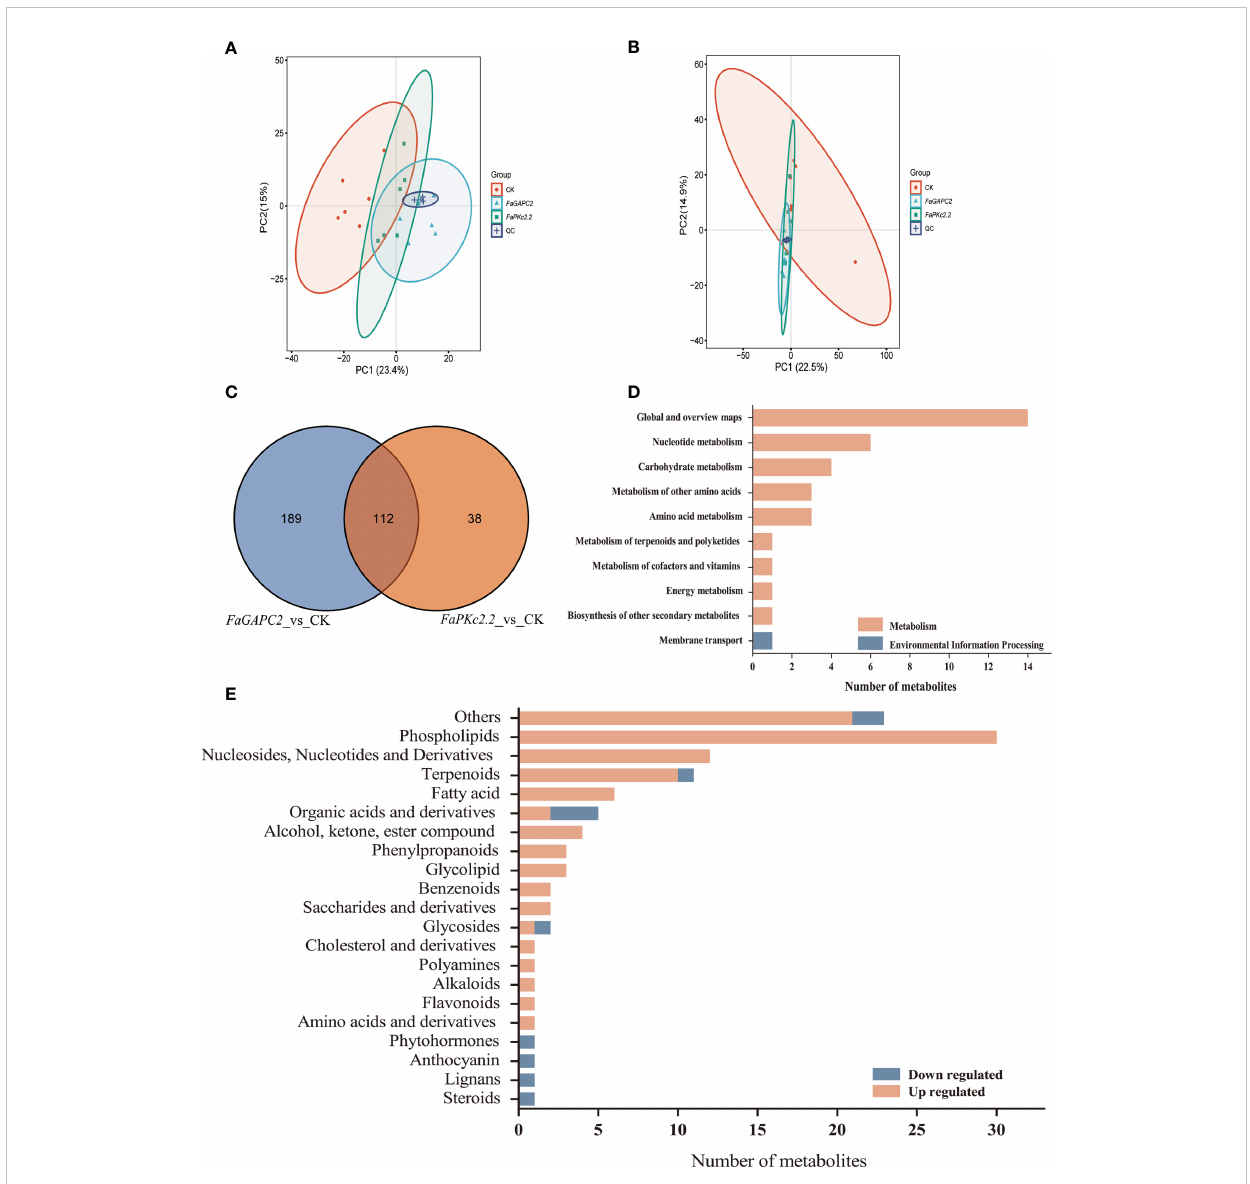
FIGURE 3 Analysis of differential metabolites in FaGAPC2 / FaPKc2.2- overexpressed fruits. Principal component analysis (PCA) score plots of strawberry fruit samples in negative ion modes (A) , PCA score plots of strawberry fruit samples in positive ion modes (B) , the Venn diagram analysis (C) , the KEGG annotation of common differential metabolites (D) , classi fi cation and the number of all the identi fi ed differential metabolites in the FaGAPC2 / FaPKc2.2 -overexpressed fruits (E) . The upregulated metabolites were labeled in orange-red and the downregulated were labeled in